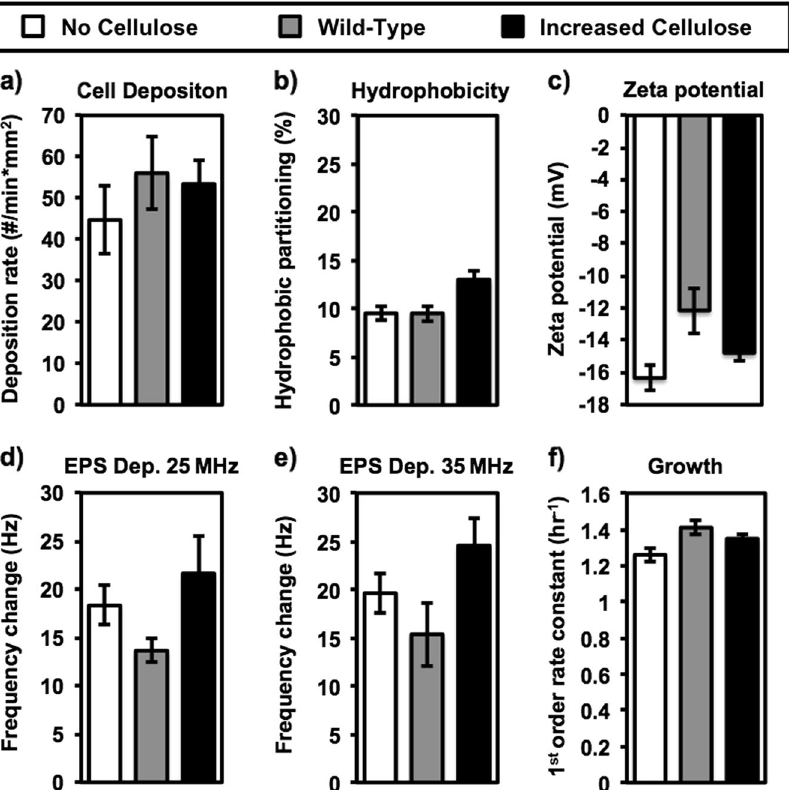
Fig. 4 Cell deposition rate ( a ); Hydrophobic partitioning ( b ); Zeta potential ( c ); QCM-D frequency change due to EPS adherence at 25 MHz ( d ); QCM-D frequency change due to EPS adherence at 35 MHz ( e ); and growth rates ( f ), for no cellulose, wild-type, and increased cellulose strains. Bacterial cell deposition was measured directly on a polypropylene membrane using a microscope-mounted fl ow cell in LBS media. Hydrophobic partitioning is based on relative af fi nity to n -dodecane of planktonic cells from cell suspension in 150 mM NaCl solution. Zeta potential was measured in 150 mM NaCl solution with OD (600 nm) of 0.1. Frequency change of QCM-D sensor is presented after 1 h exposure of 12.5 mg/l as TOC of extracted EPS in 0.34 M NaCl solution for sensor frequencies at either 25 MHz or 35 MHz. Cell growth was observed in LBS media by spectrophotometer at 25 °C. All error bars represent 1 standard